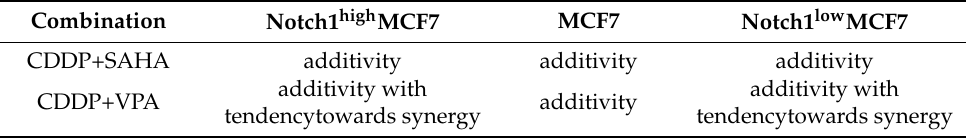
Table 3. Isobolographic analysis of interactions between CDDP and SAHA or VPA at the fixed-ratio combination of 1:1 on cells with increased or decreased activity of Notch1 with reference to native MCF7 cells